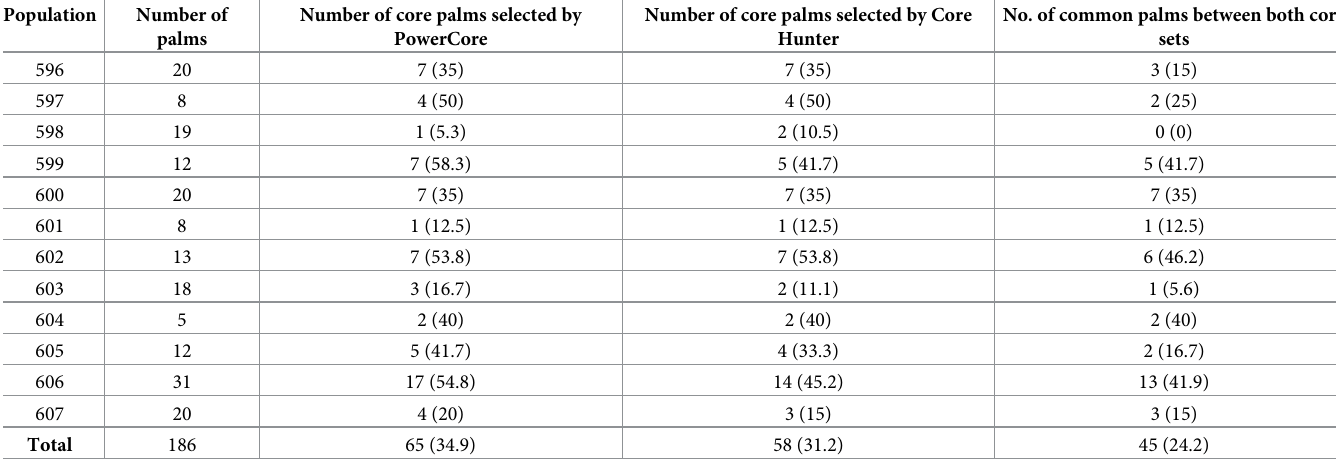
Table 5. Summary of core collections developed using PowerCore and Core Hunter.